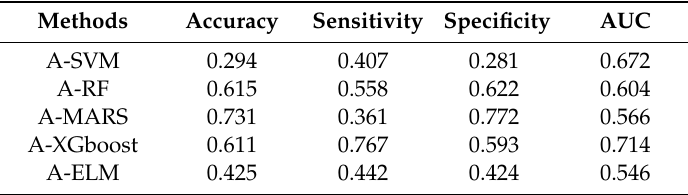
Table 4. Classification results of the five two-stage methods.